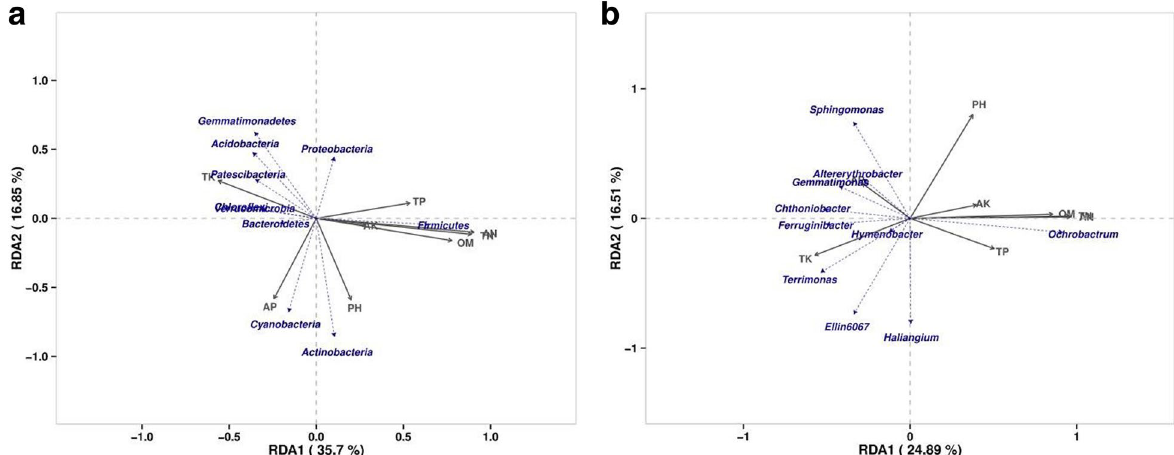
Fig. 5 RDA of soil microbial community structure and soil physicochemical properties. a Horizontal community structure of bacterial phylum. b Horizontal community structure of bacterial generic